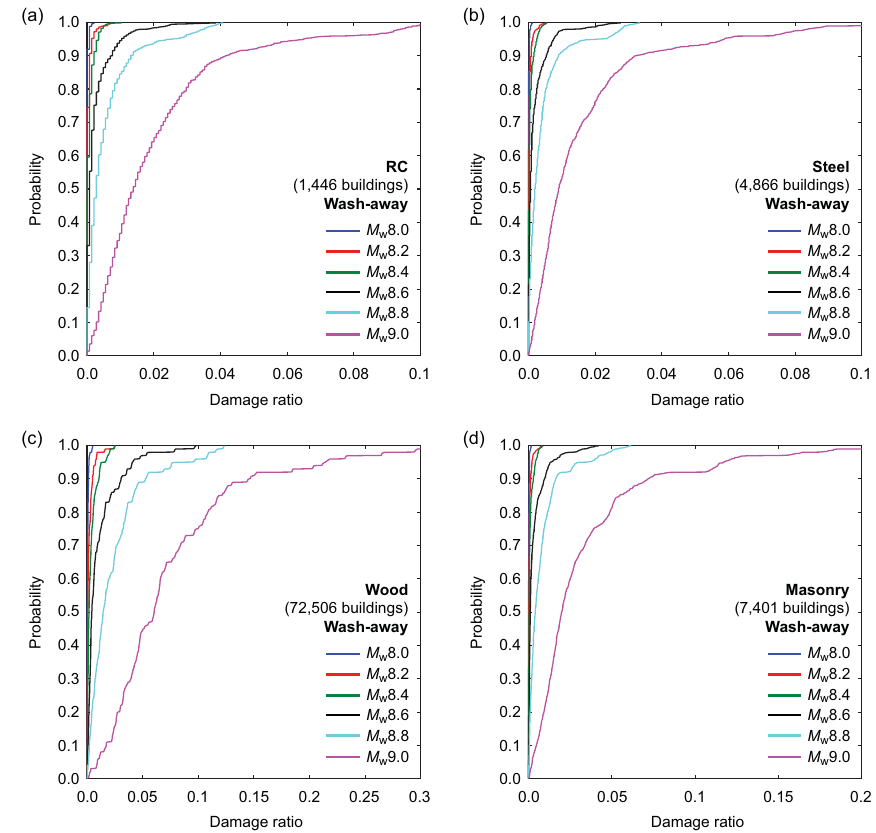
Figure 6. Probability distributions of wash-away damage ratios (i.e., percentages of damaged buildings to all buildings) for different earth- quake scenarios by distinguishing material types: (a) RC, (b) steel, (c) wood, and (d)